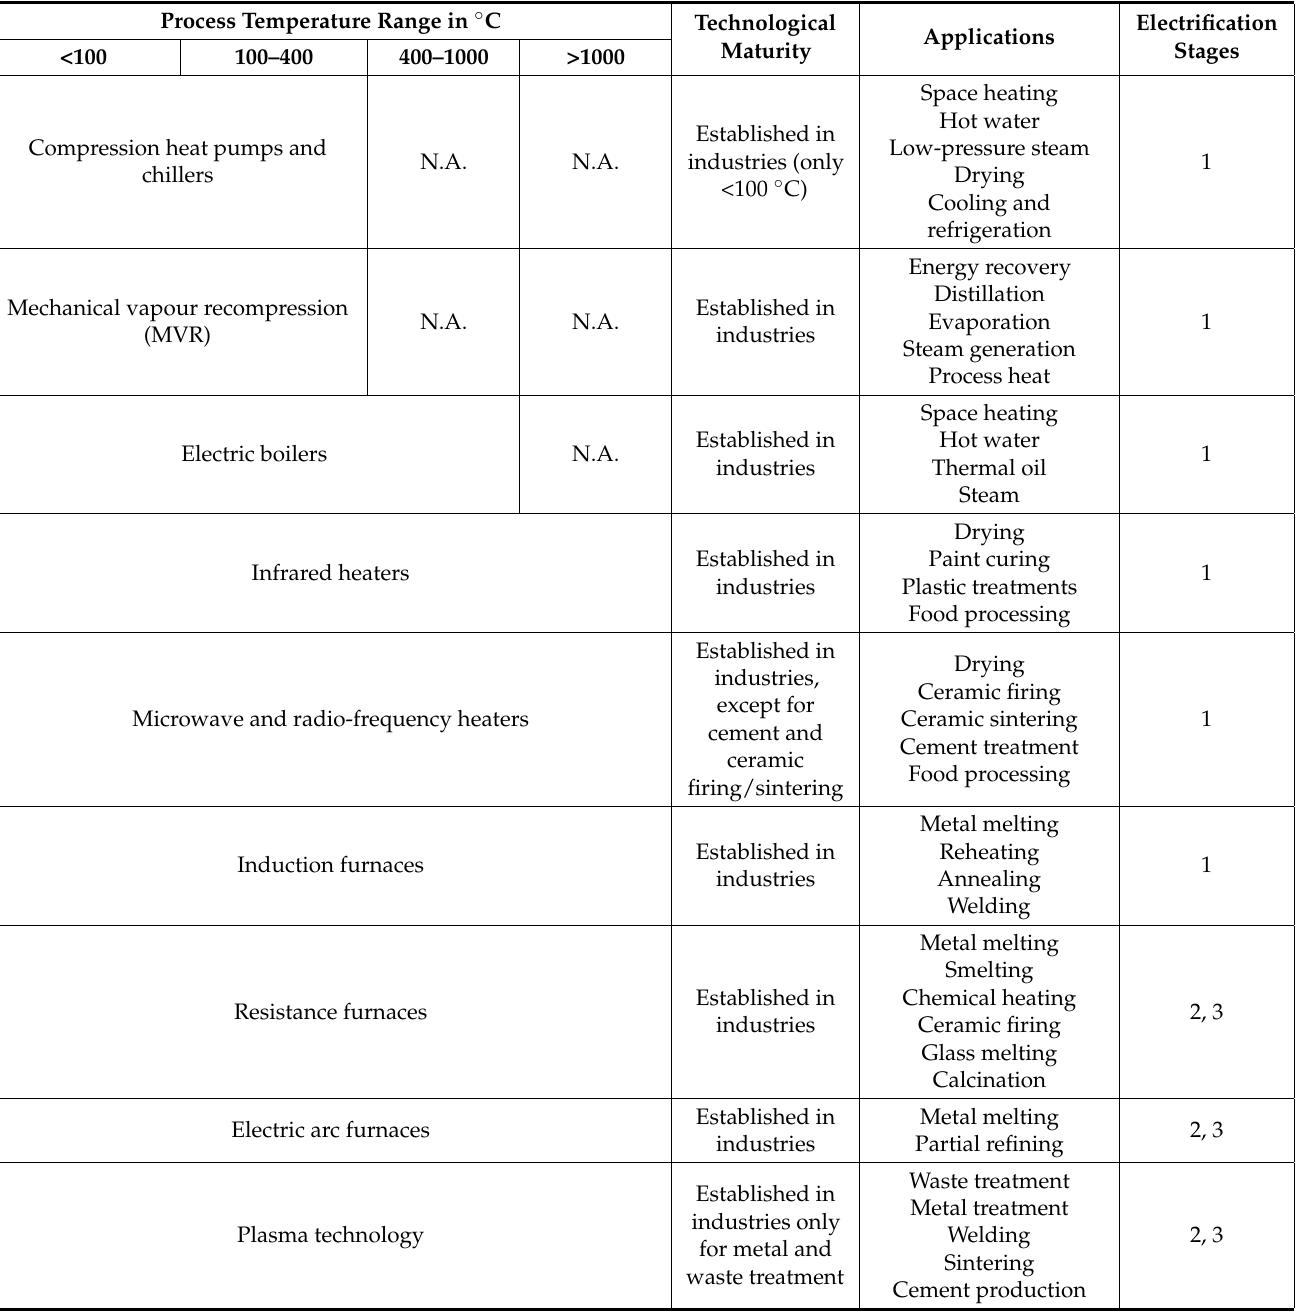
Table 1. Renewable electricity-based technologies for the electrification of industrial